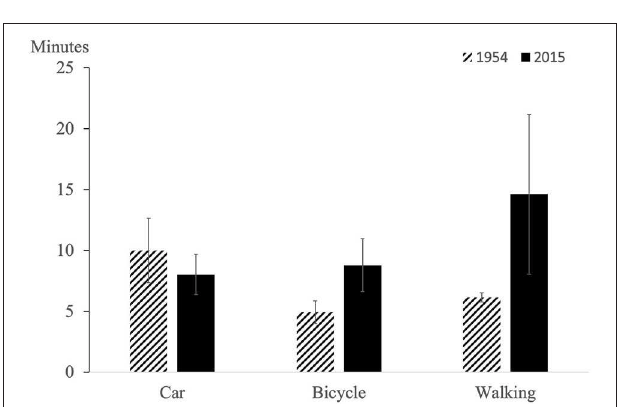
be threatened by urban development, human use, edge effects,